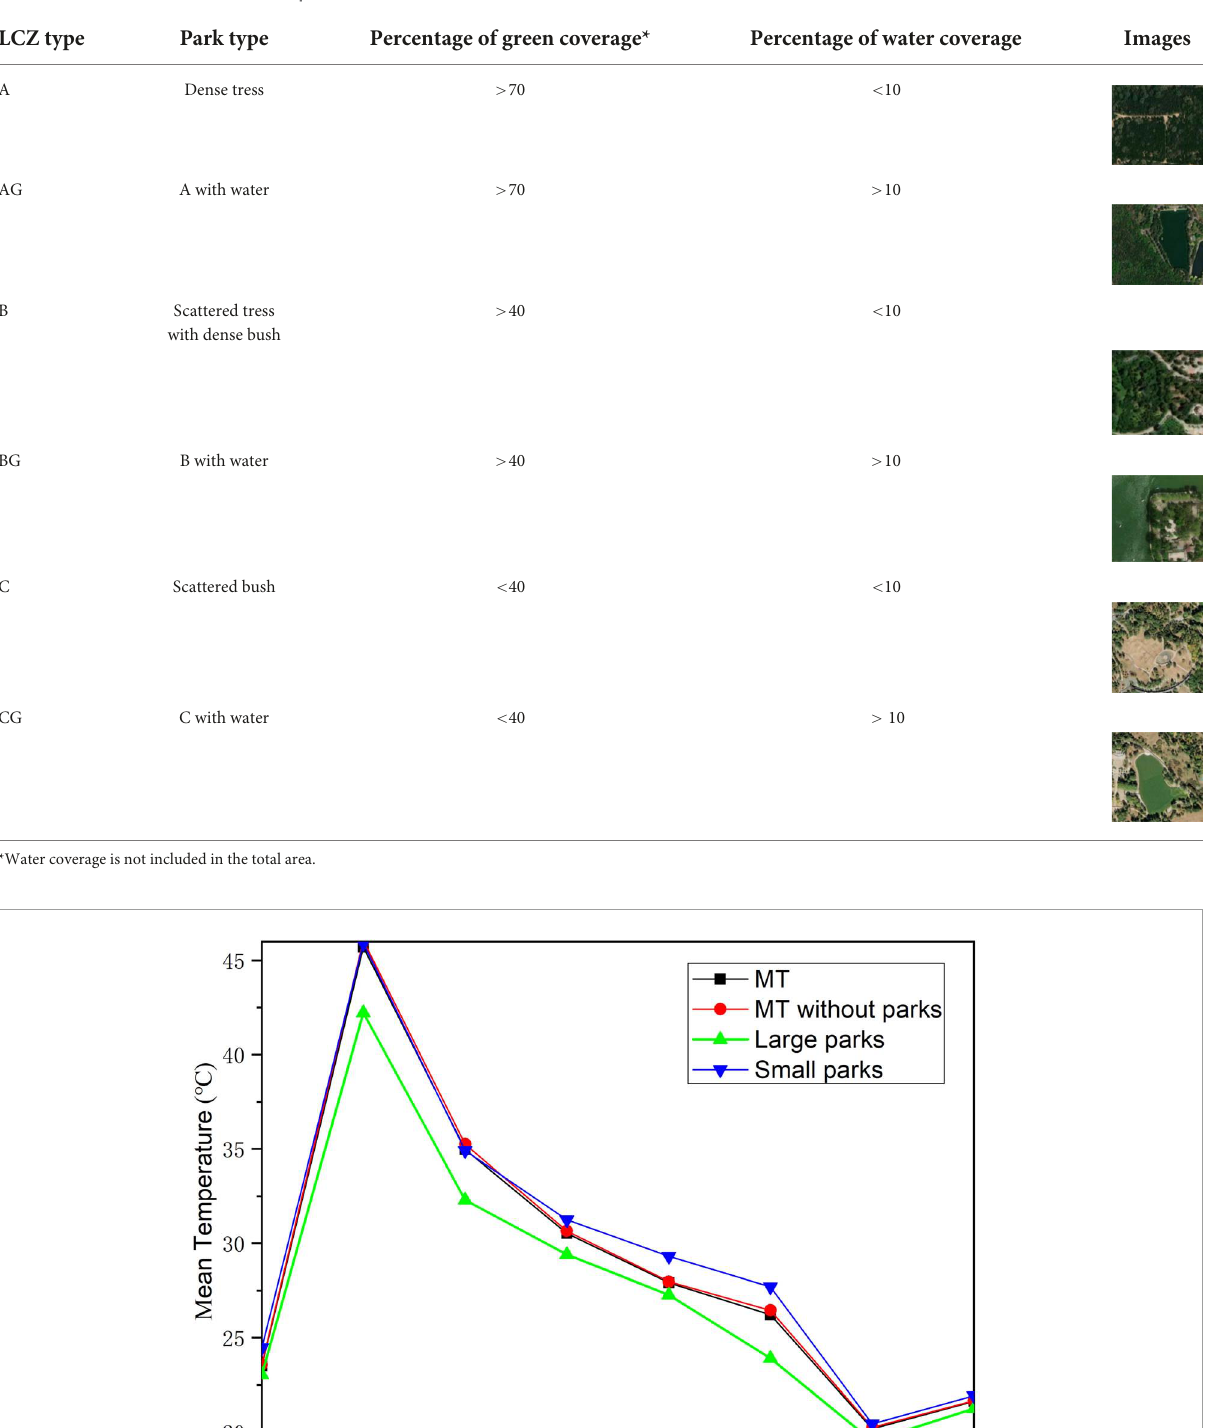
TABLE 2 LCZ classification of urban park.